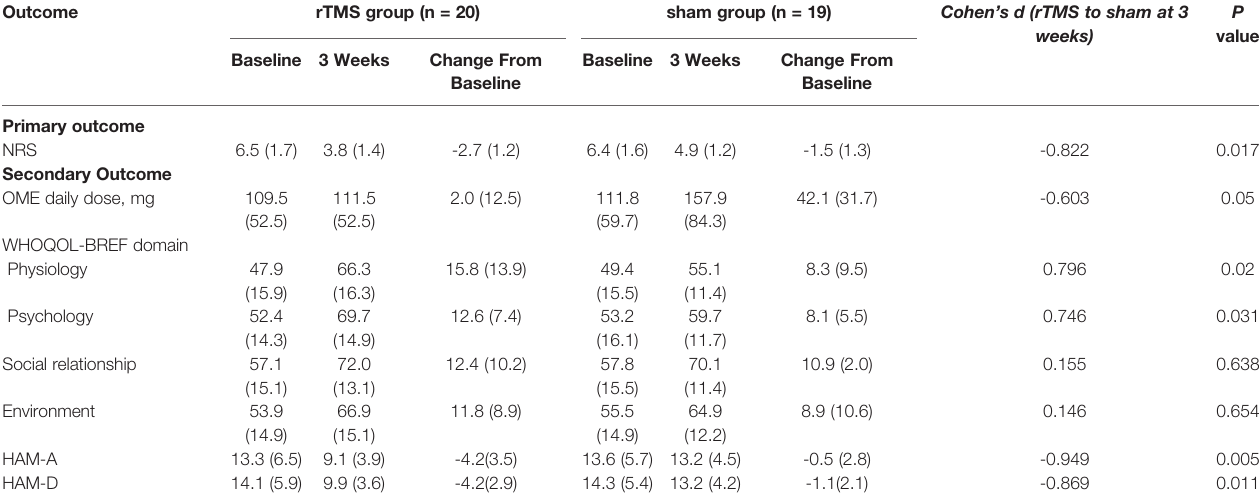
TABLE 2 | Primary and Secondary